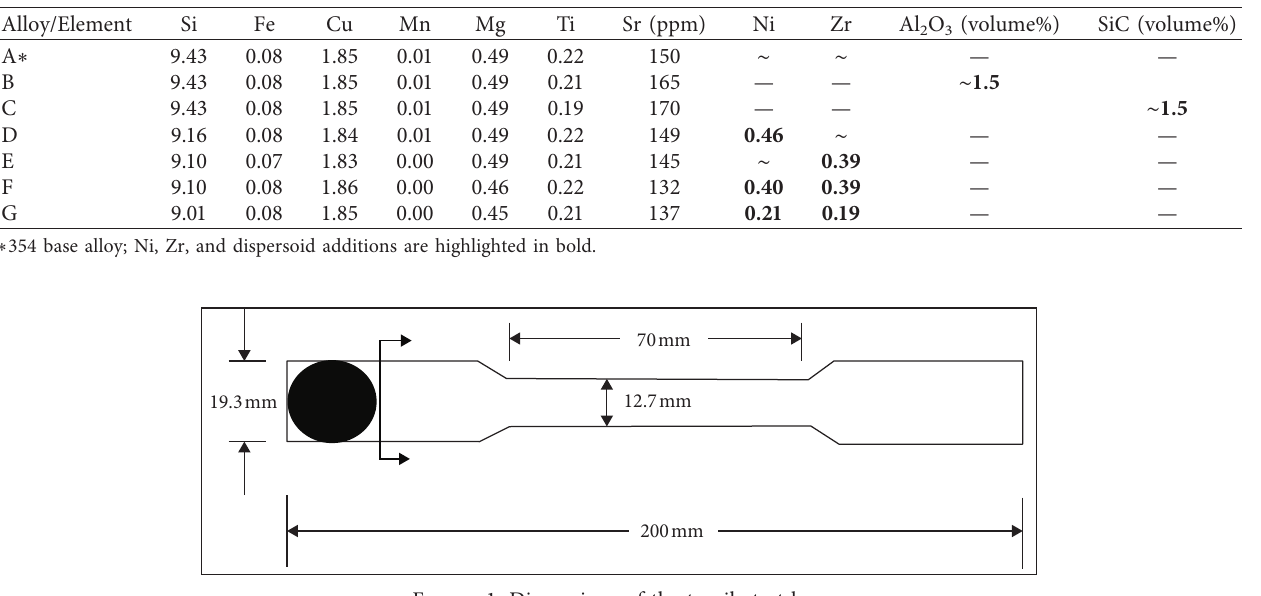
Figure 1: Dimensions of the tensile test